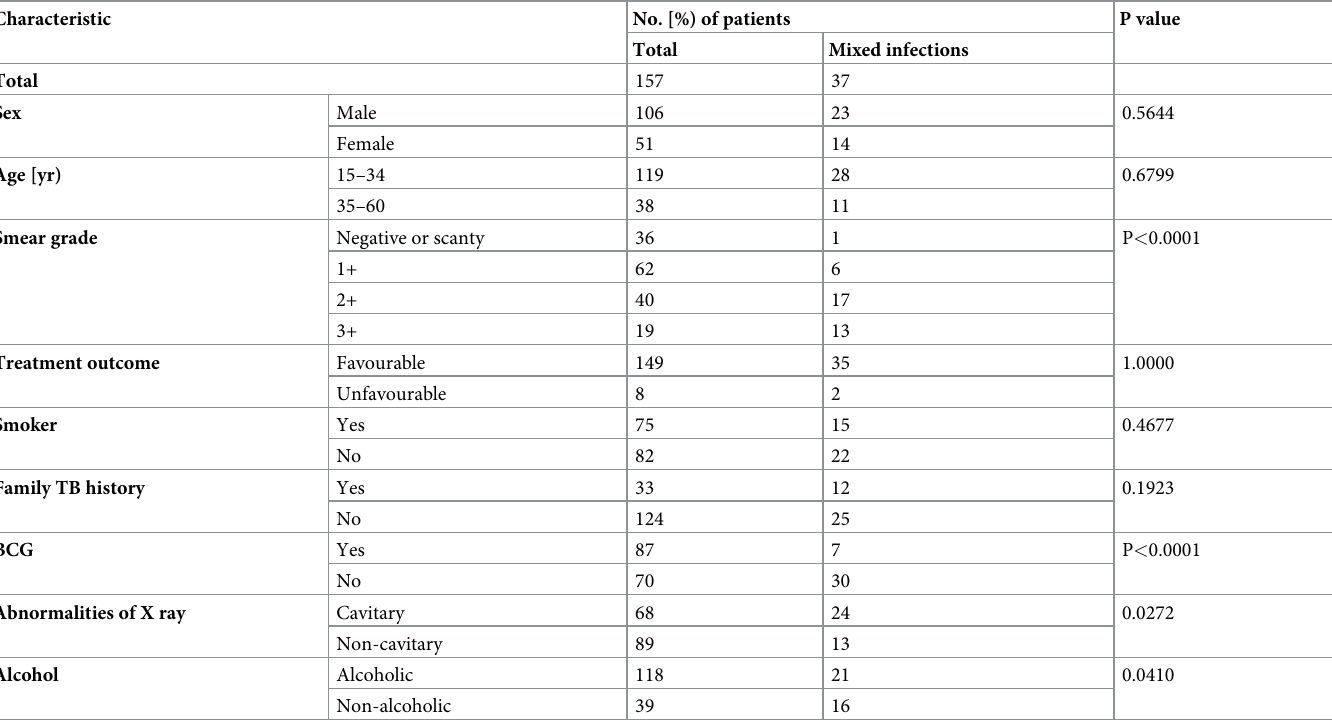
Table 1. Risk factors associated with polyclonal disease. (P value is calculated by Fisher’s exact test. A p-value of < 0.05 was regarded as significant).